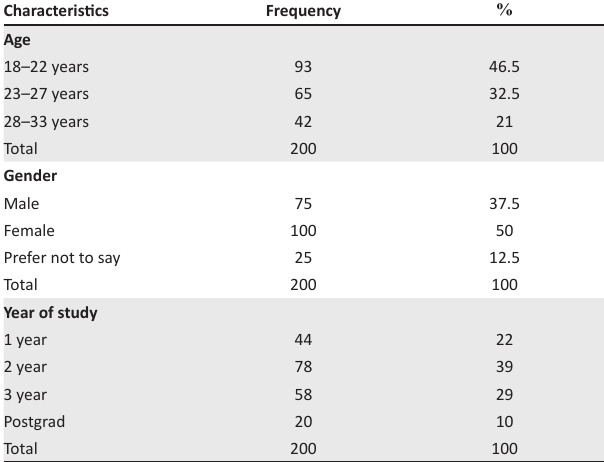
TABLE 2: Sample demographic characteristics. TABLE 1: Measurement scales and their